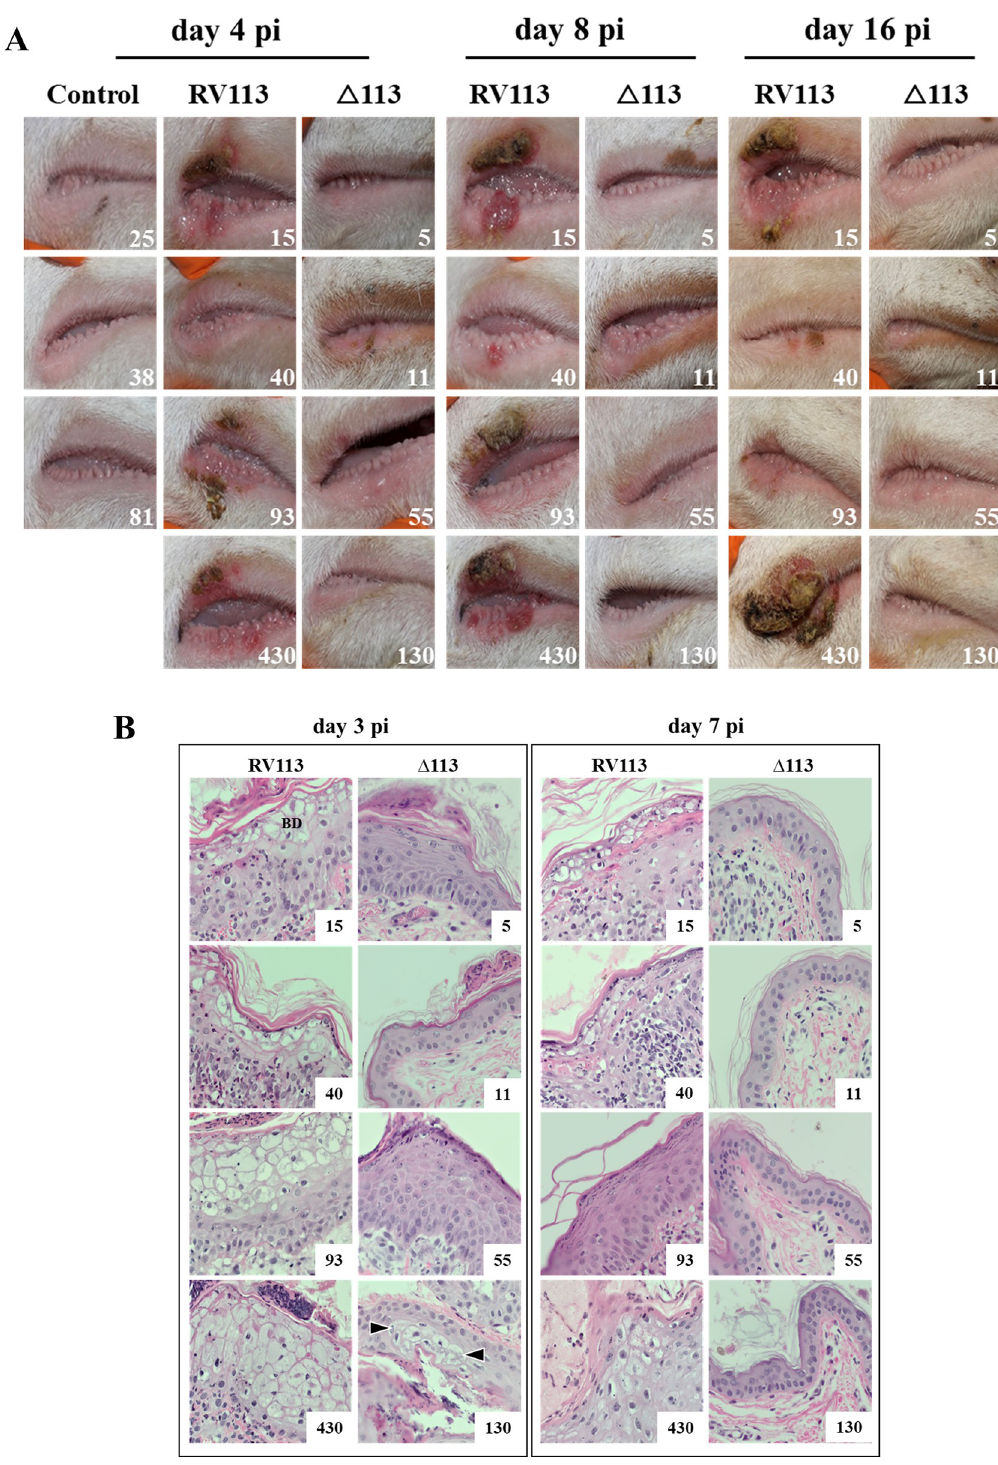
Fig 9. Effect of ORFV113 on virus virulence and pathogenesis in sheep. (A) Sheep were scarified in the right labial commissure, inoculated with virus OV-IA82RV113 HA (RV113; sheep # 15, 40, 93, and 430) or OV-IA82 Δ 113 ( Δ 113; sheep # 5, 11, 55 and 130), or treated with PBS (control; sheep # 25, 38 and 81), and monitored for 20 days. Gross changes are shown for days 4, 8 and 16 p.i. (B) Histological changes in the skin of the inner side of thighs following inoculation with OV-IA82RV113 HA (RV113) or OV-IA82 Δ 113 ( Δ 113). Representative histopathological changes are shown for days 3 and 7 p. i. H&E staining, X 400. BD, area of ballooning degeneration; arrowheads, restricted BD. https://doi.org/10.1371/journal.ppat.1009971.g009 PLOS Pathogens| https://doi.org/10.1371/journal.ppat.1009971 October 6,